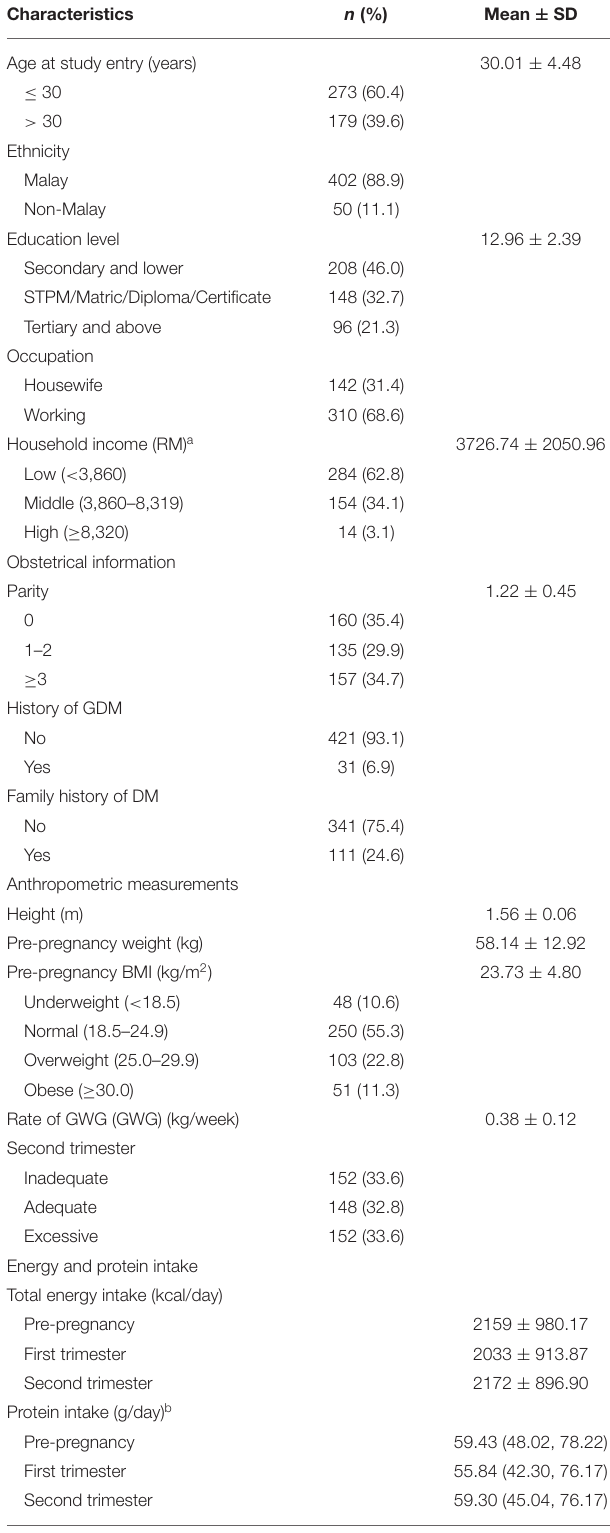
TABLE 1 | The characteristics of the women ( n =